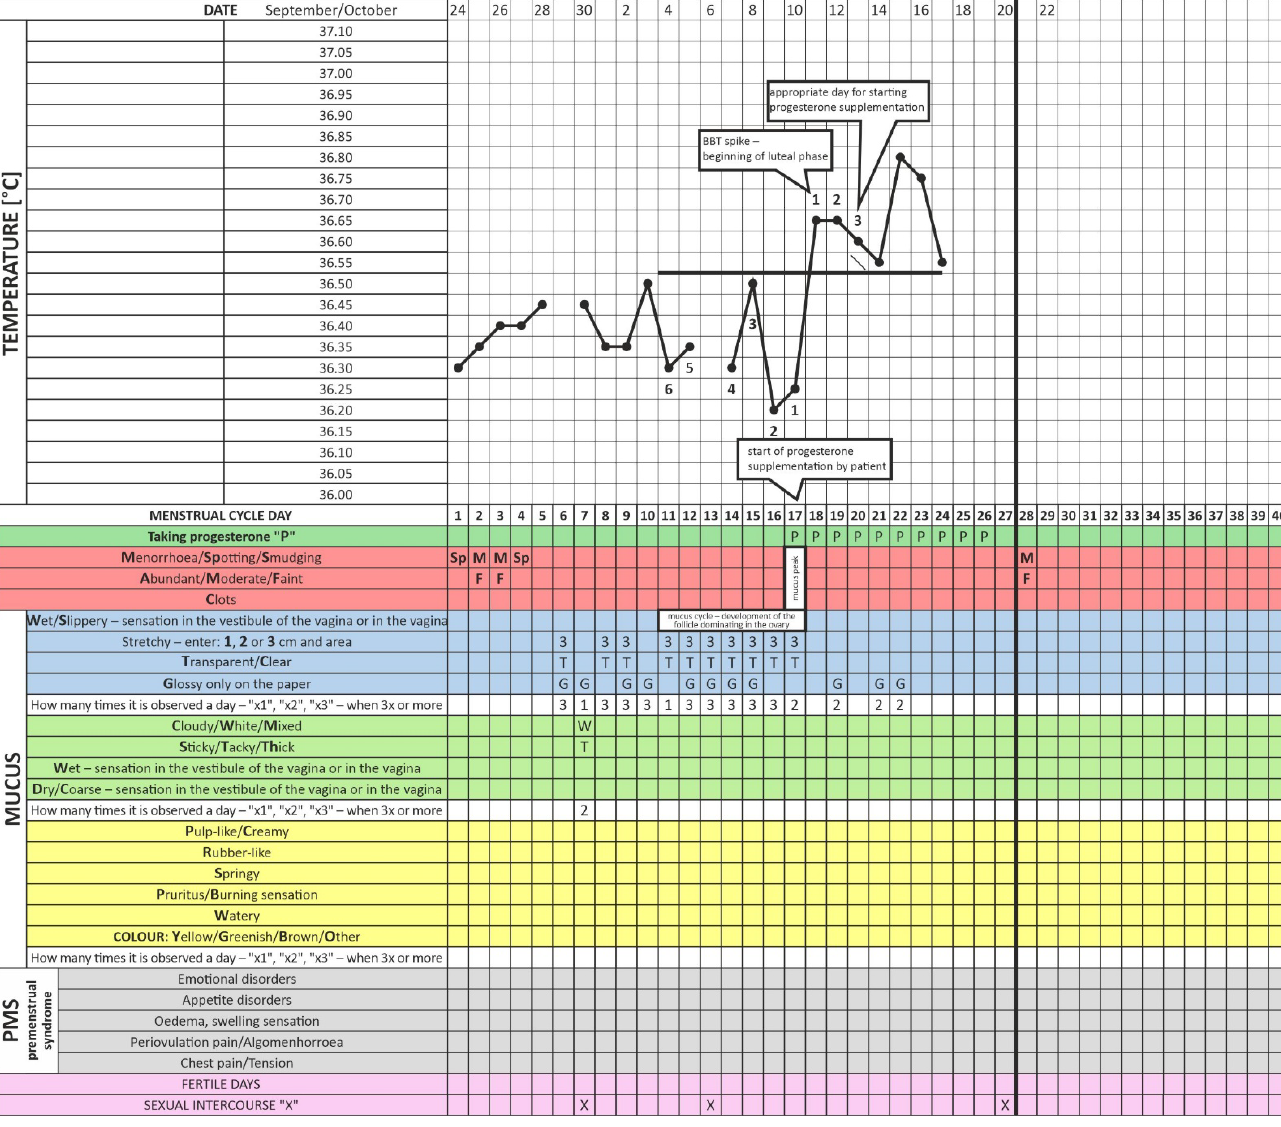
Figure 2. Menstrual cycle observation chart at the time when the patient started taking progesterone incorrectly—too early— (i.e., Day 17 of the menstrual cycle).